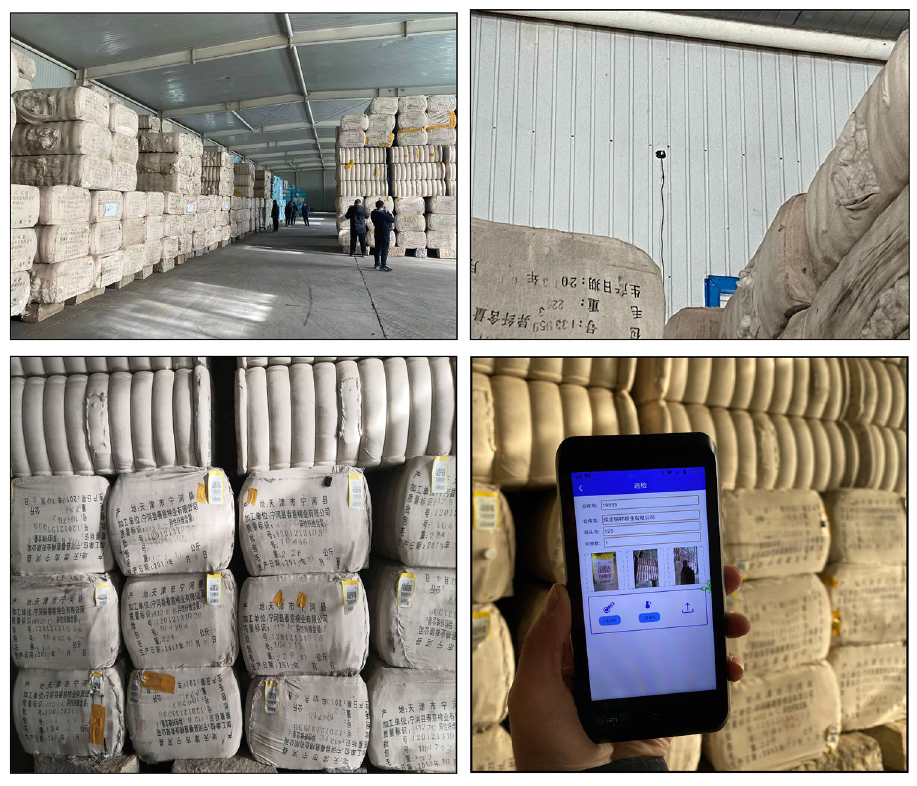
Figure 17. Field test of bale positioning inspection.